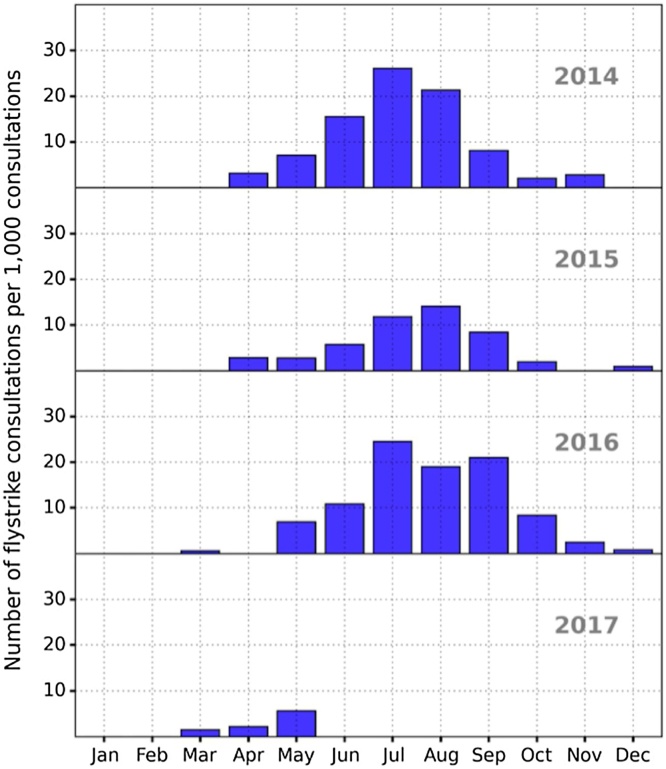
Annual seasonal pattern of blowfly strike consultations (per 1000 rabbit consultations) between April 2014 and May 2017.